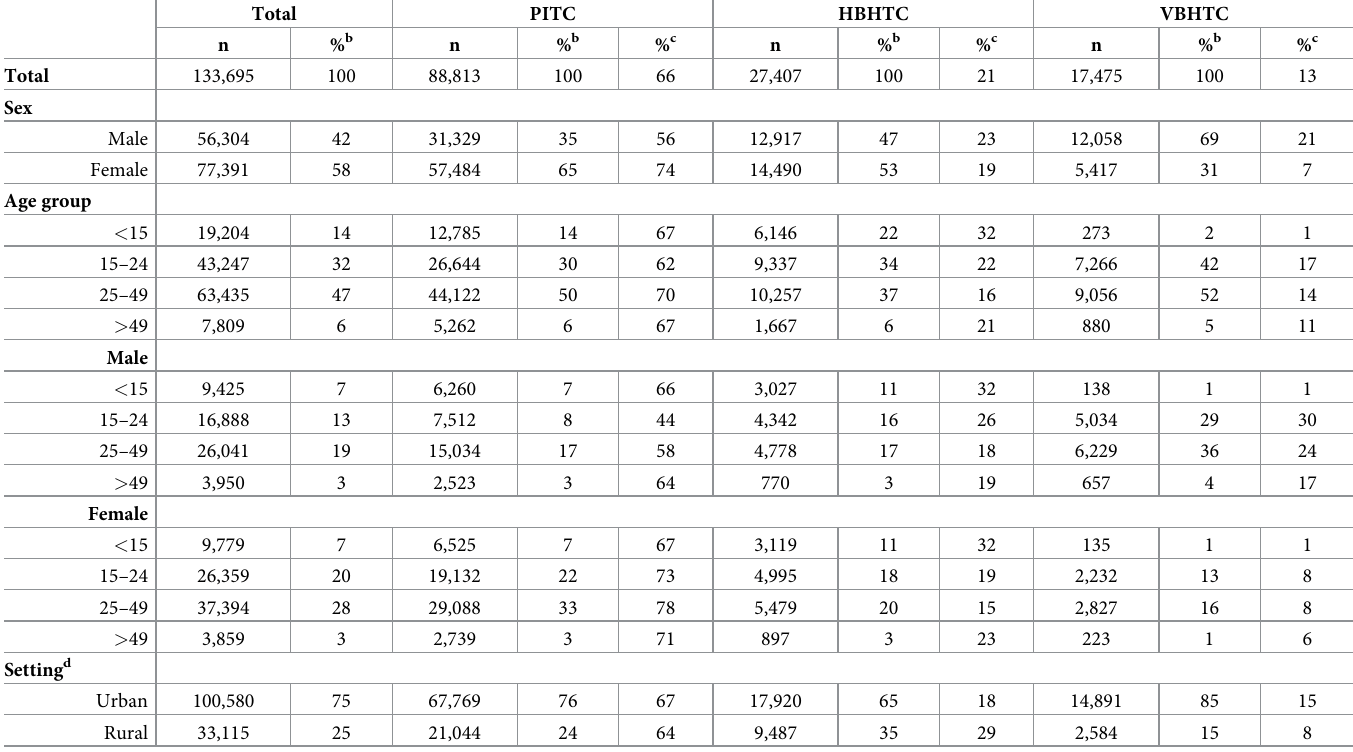
Table 1. HIV tests conducted, by demographic characteristics and HIV testing strategy, Bukoba Combination Prevention Evaluation, Tanzania, 2014–2017 a